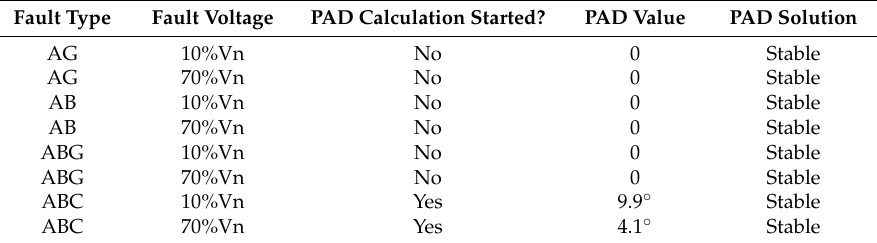
Table 5. Stability of PAD solution with default settings under different system faults.